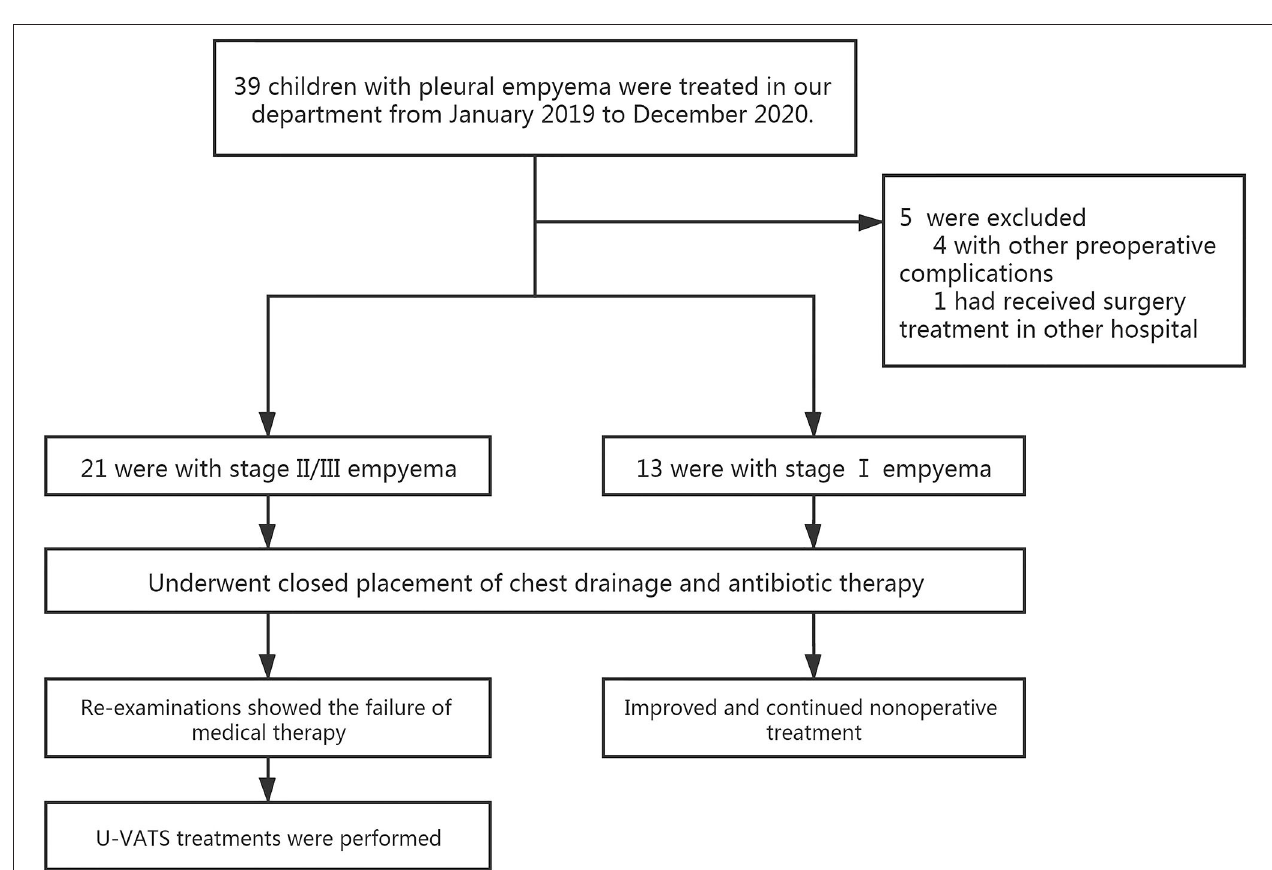
FIGURE 2 | CONSORT flow diagram of